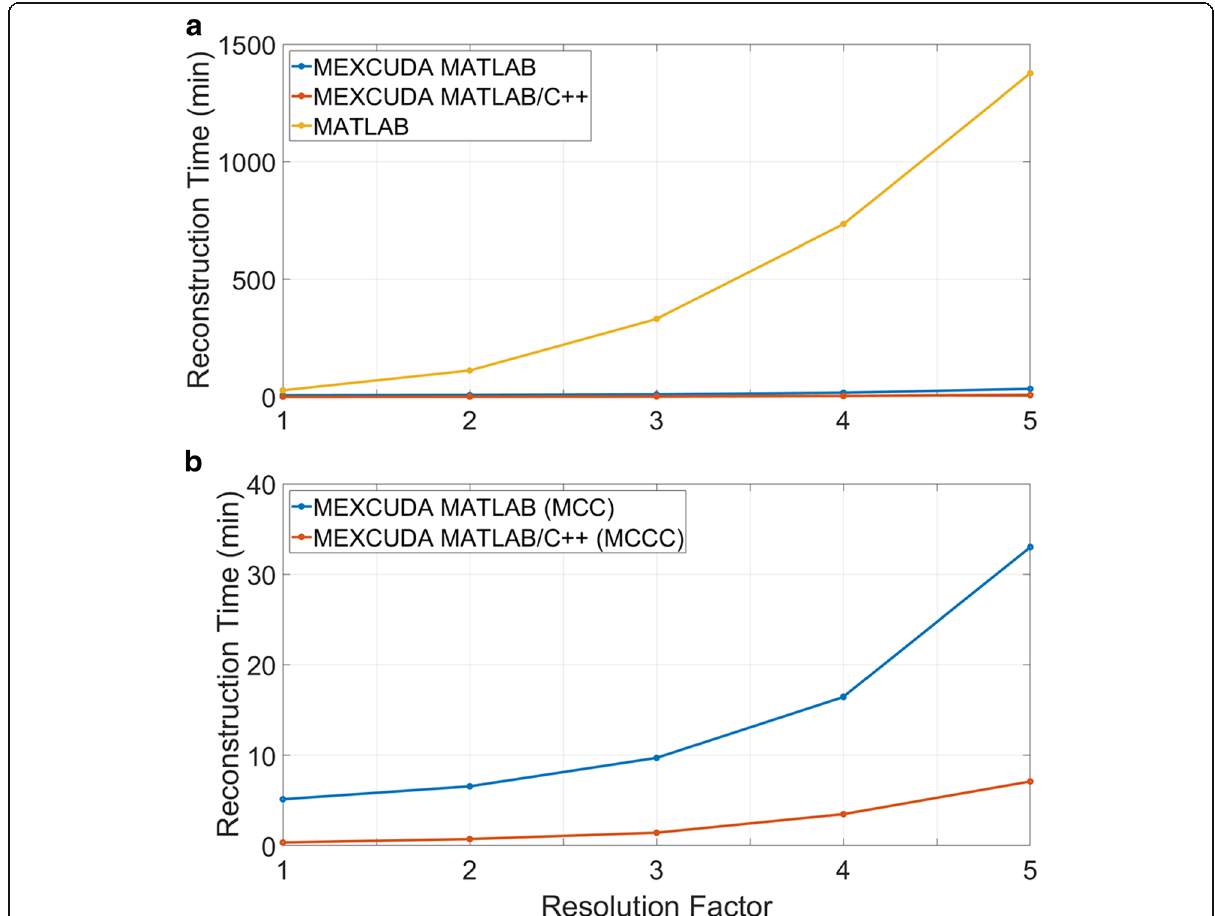
Fig. 4 a Comparison of reconstruction time between MCC, MCCC and MWGC and b a close look into reconstruction time difference between MCC and MCCC codes with different RF